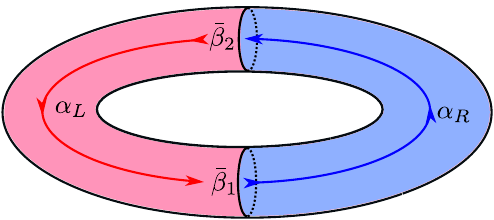
Figure 7 . The states on torus with two noncontractible interfaces can be generated by the path integral with Wilson line insertions (cid:11) L and (cid:11) R as long as they have mutual branching channels (cid:22) (cid:12) 1 and (cid:22) (cid:12) 2